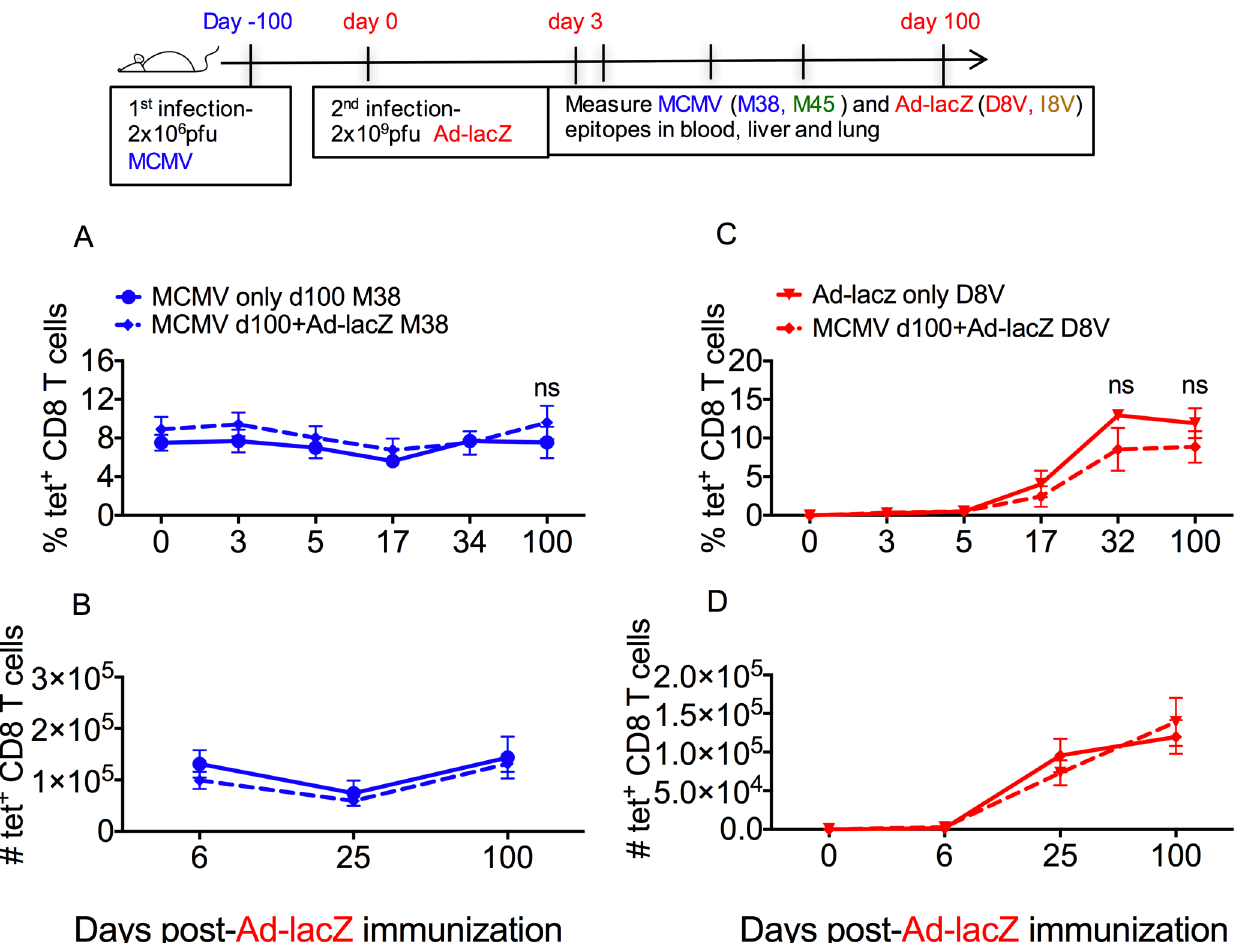
Fig 2. Sequential infection with MCMV followed by Ad-LacZ. (A) C57BL/6 mice were first infected with MCMV, then > 50 days later were infected with Ad-lacZ. The size of the pre-existing MCMV specific M38 effector memory response after Ad-lacZ infection was measured in the blood and liver by ex-vivo tetramer staining. The percentage of pre-existing M38 response in the blood and (B) the absolute numbers in the liver after immunization with Ad-lacZ vector was determined at the indicated time points. (C) The kinetics and magnitude of the new inflating response (D8V) in groups of mice with latent MCMV was also measured by ex vivo tetramer staining compared against uninfected mice. The percentage of D8V tetramer+ cells in the blood and (D) the absolute numbers in the liver was measured at the indicated time points. The figures show the mean from 3–8 mice per time point obtained from 2 independent experiments. p values were measured by Mann-Whitney tests. (cid:3) p < 0.05.